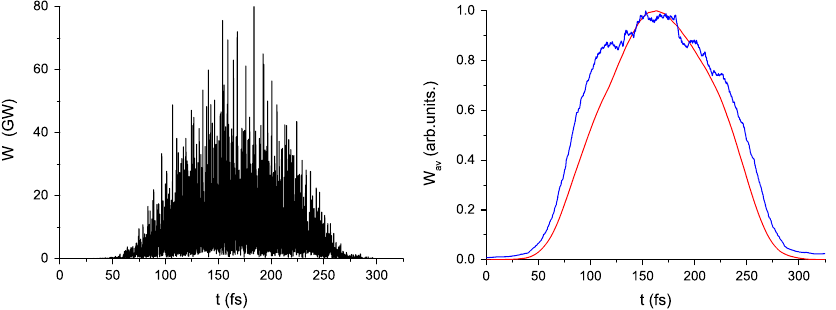
FIG. 10. (Color) Left: Power distribution in a single x-ray pulse from the SASE1 undulator [12]. This shot was used to calculate beam modulations in Fig. 4. Right: Averaged power distribution (red) and its reconstruction (blue), see the text for